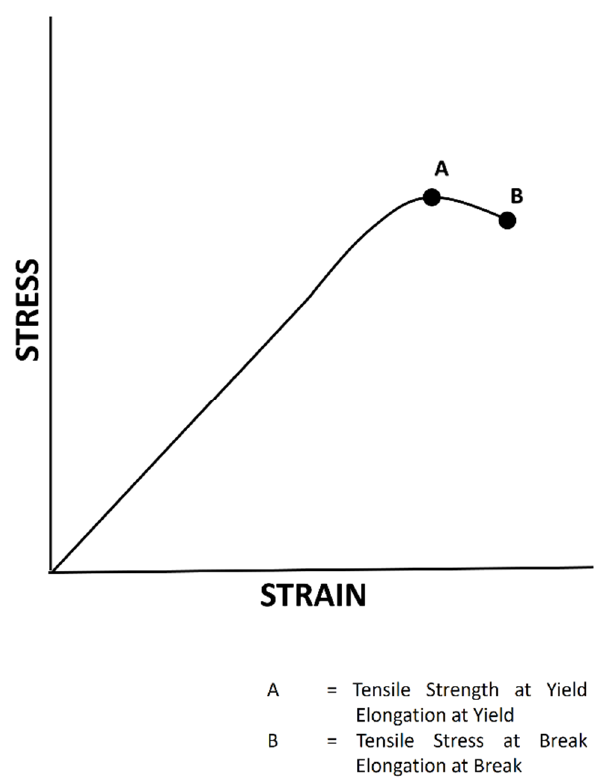
Figure 4. An illustration of a load–elongation curve from a tensile test.